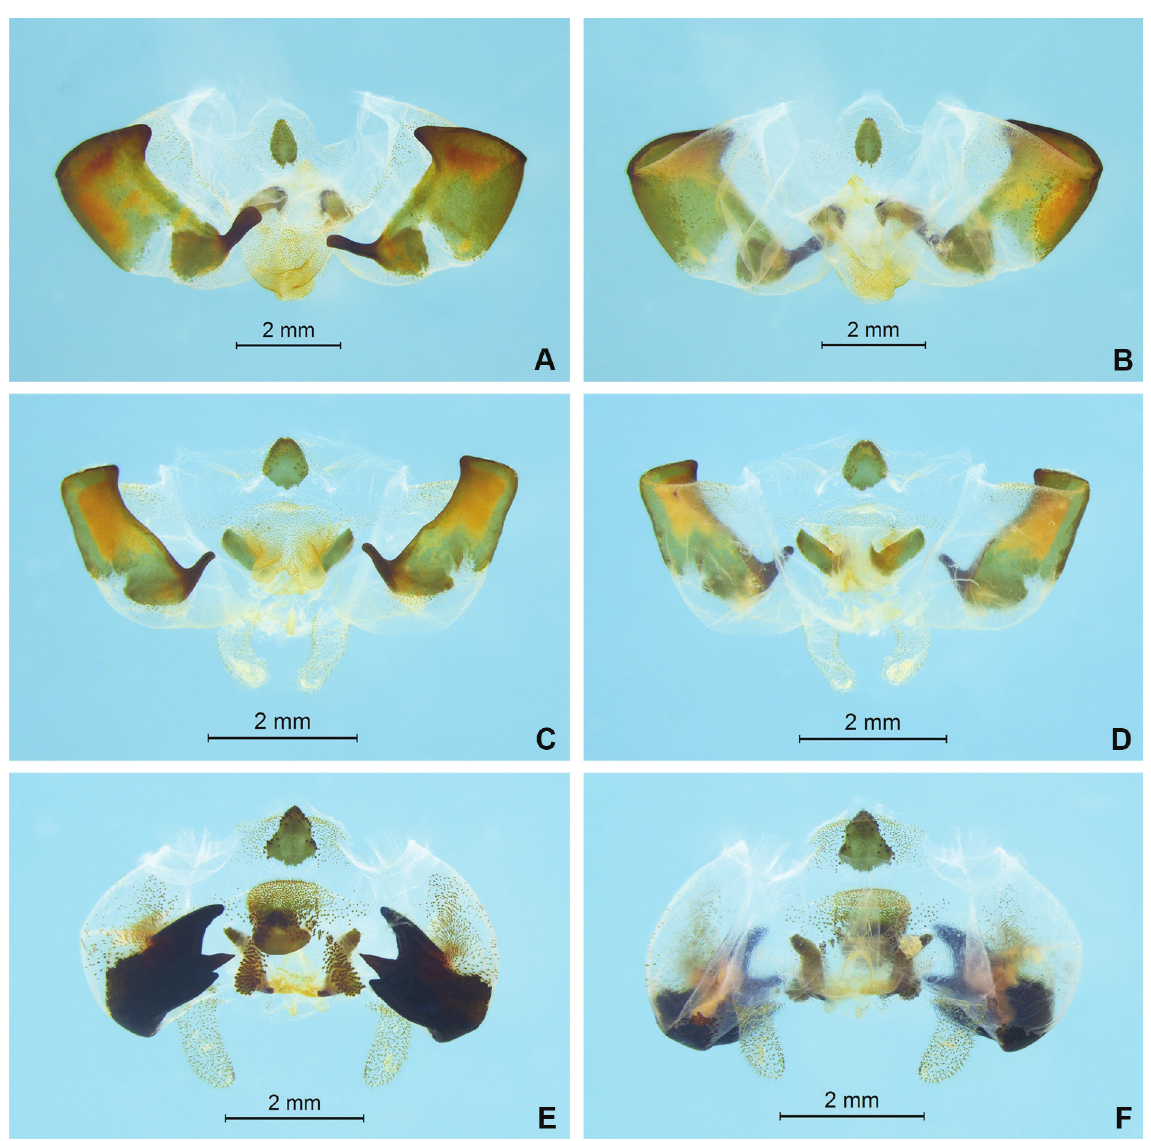
Fig. 5. Male genitalia. A , C , E . Dorsal view. B, D, F . Ventral view. A–B . Megatachycines pentus gen. et sp. nov., paratype, ♂ (HBU). C–D . Megatachycines elongatus (Qin, Liu & Li, 2017) comb. nov. E–F . Megatachycines trispinosus (Qin & Li, 2020) comb.